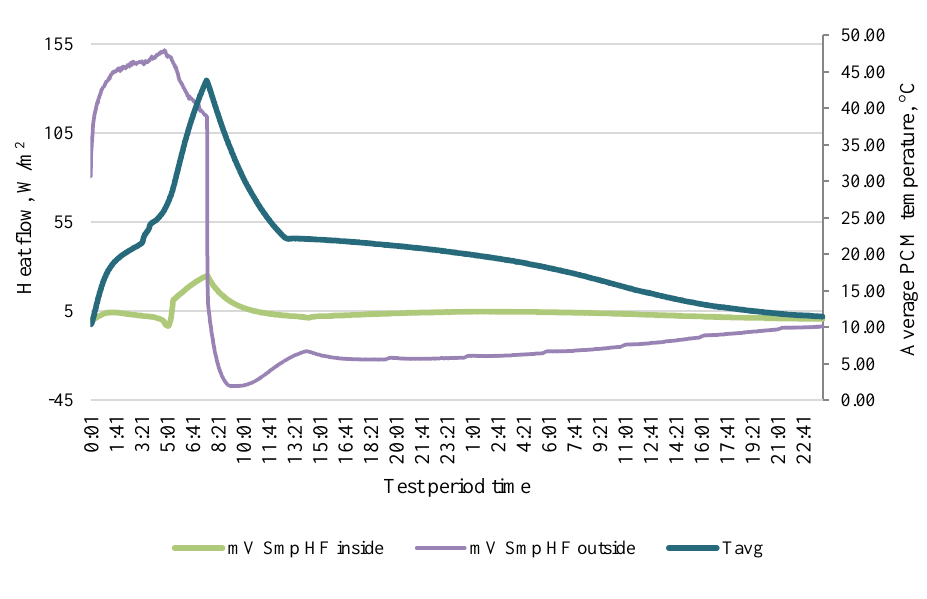
Fig. 9. Heat flow and PCM average temperature, Setup